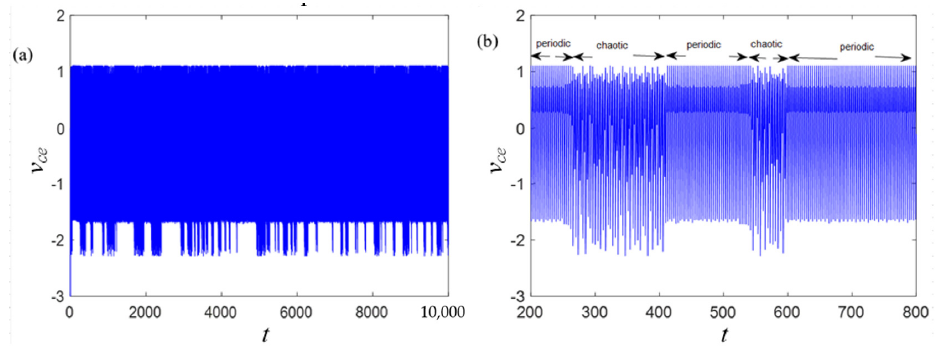
Figure 12. Time-domain waveform of v ce when R = 228.6 and the initial conditions are [0.1, 0, − 1, 0.1]: ( a ) t ∈ [0, 10,000], ( b ) t ∈ [200, 800].